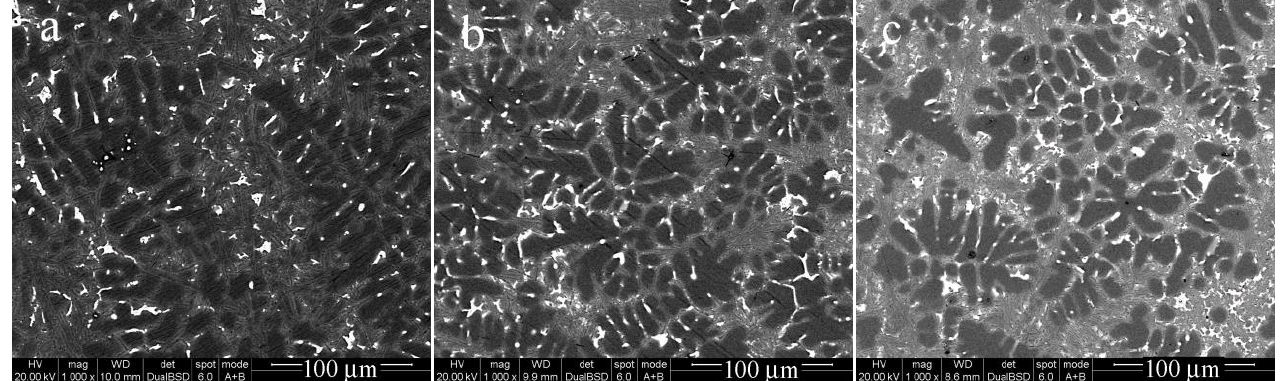
Figure 8. SEM microstructures of as-cast Al-9.8% Si-2% Cu alloys with B contents of ( a ) 0 wt.%; ( b ) 0.02 wt.%; and ( c ) 0.05 wt.%.